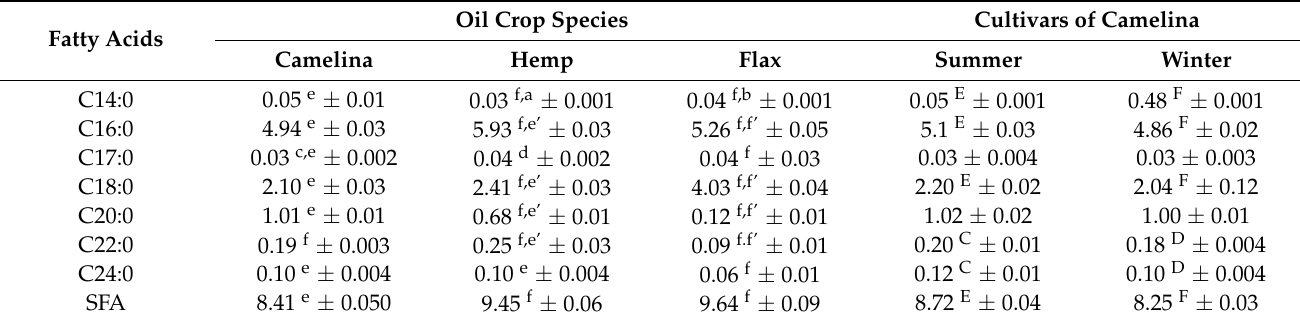
Table 2. Effects of oil crop species and cultivars of different sowing seasonality on saturated fatty acid (% of total FA) composition in seed